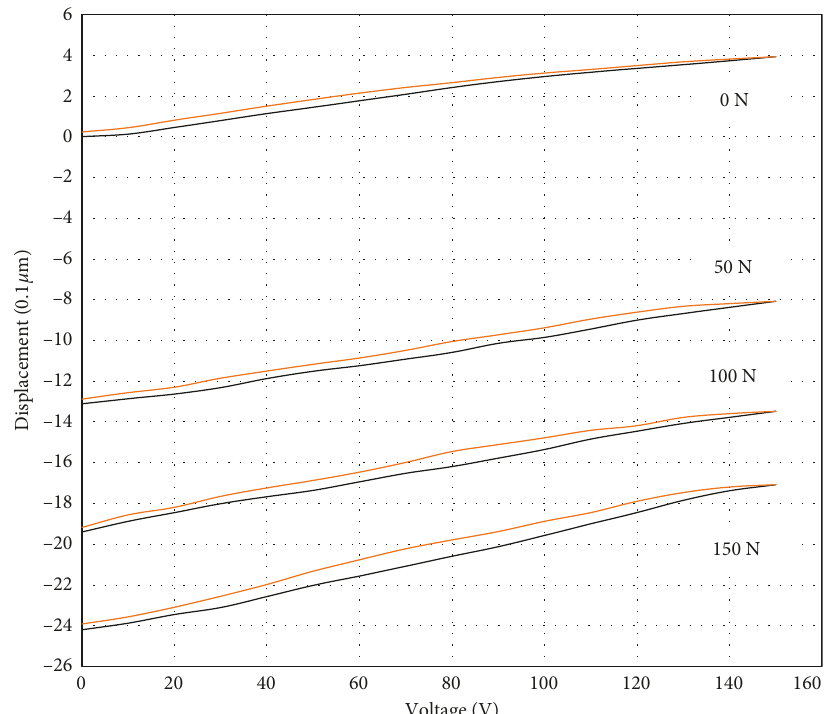
Figure 3: Displacement of KNN element in the asphalt concrete under different loads.